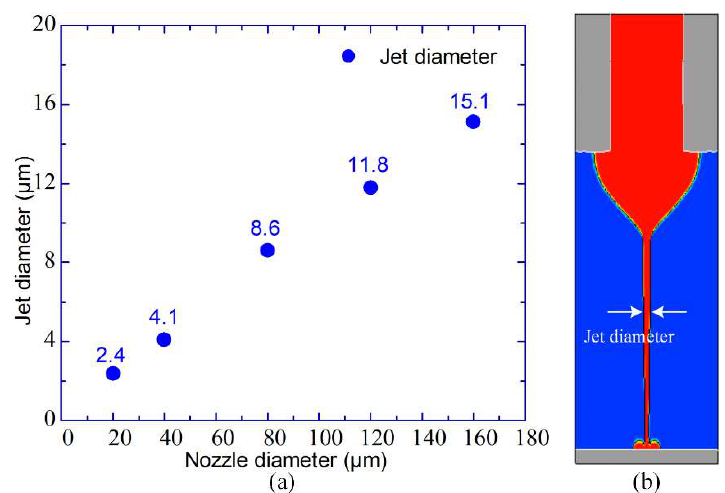
Figure 9. ( a ) Relation between nozzle diameter and jet diameter. ( b ) An example of a jetting image that is adopted to measure jet diameter when a 160 μm nozzle is utilized.